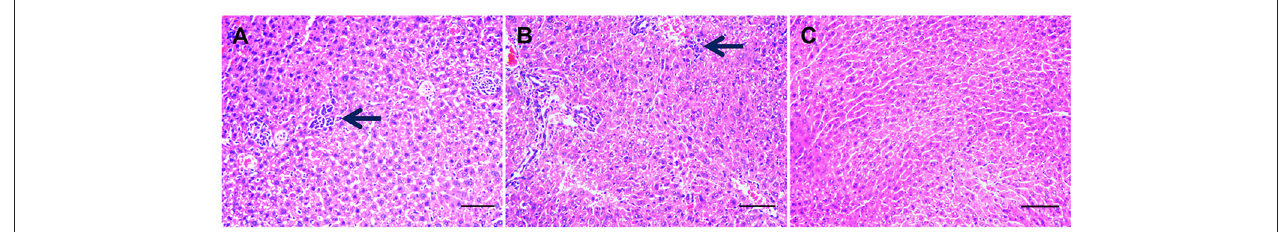
FIGURE 1 | Histopathological changes in the liver tissues from Toxoplasma gondii -infected mice. Histopathological analysis was conducted on livers from mock- and T. gondii -infected mice at days 11 and 30 postinfection. Photomicrographs of liver tissue sections stained with hematoxylin and eosin (original magnification, × 100). (A) Liver section from a mouse on day 11 postinfection. Liver shows multifocal mononuclear cell aggregations (mainly lymphocytes, arrow) with numerous vacuolated hepatocyte. (B) At 30 dpi, liver shows mild mononuclear cellular infiltration (arrow), increased numbers of Von Kupffer cells besides numerous pyknotic hepatocytes. (C) Hepatic tissue from mock-infected, control mice shows a normal histological structure.